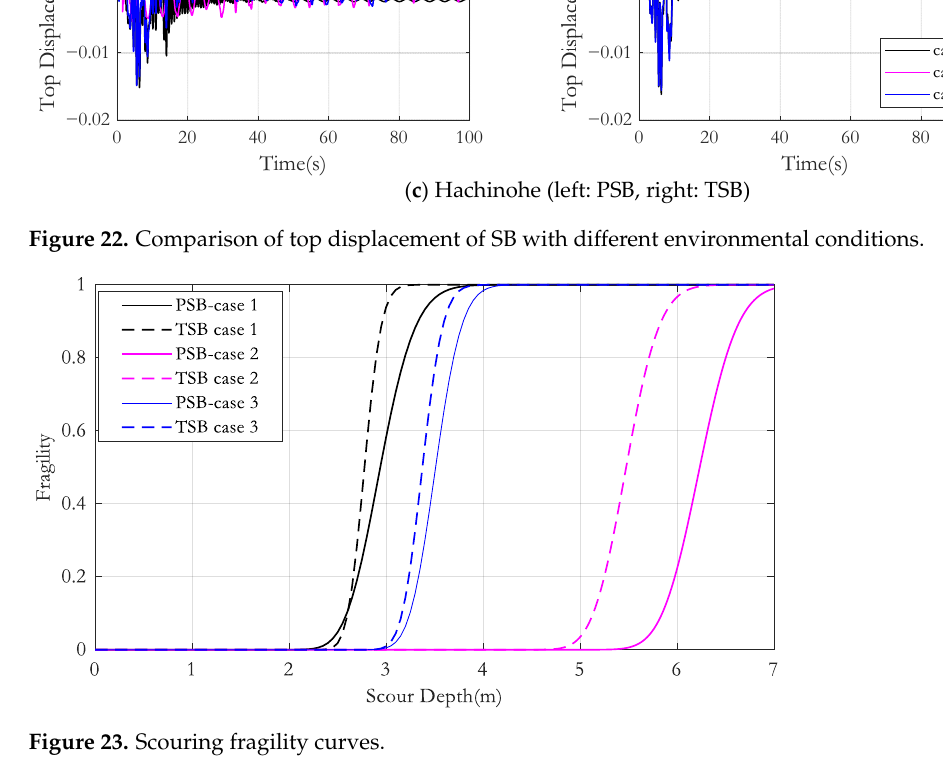
Figure 23. Scouring fragility curves.